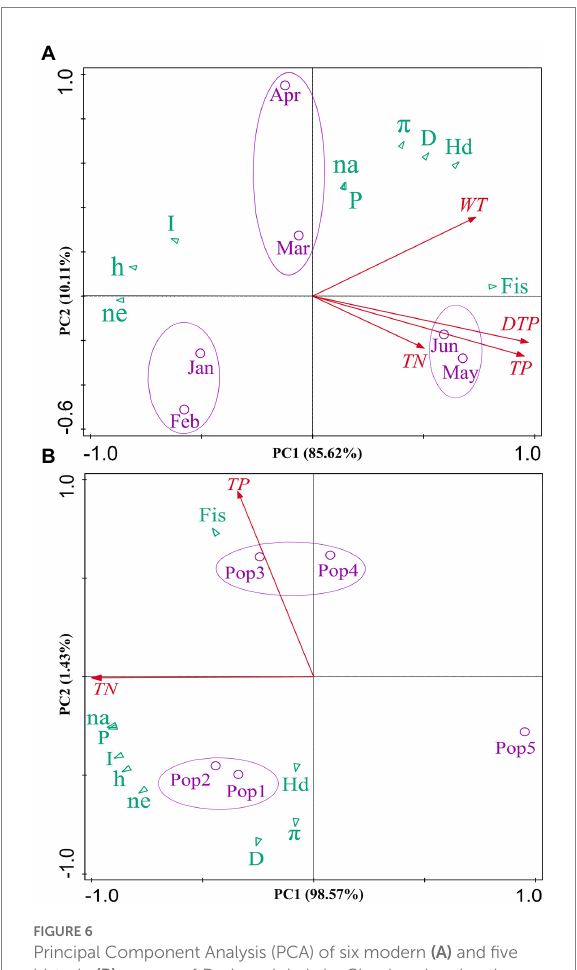
FIGURE 6 Principal Component Analysis (PCA) of six modern (A) and five historic (B) groups of D. sinensis in Lake Chaohu, showing the relationships between different genetic diversity indexes and environmental factors. Na stands for the observed number of alleles, Ne -the effective number of alleles, h -Nei’s gene diversity, I -Shannon’s diversity index, P -percentage of polymorphic loci, Fis -inbreeding coefficient, Hd -haplotype diversity, π -Nucleotide diversity, D -the genetic distance within